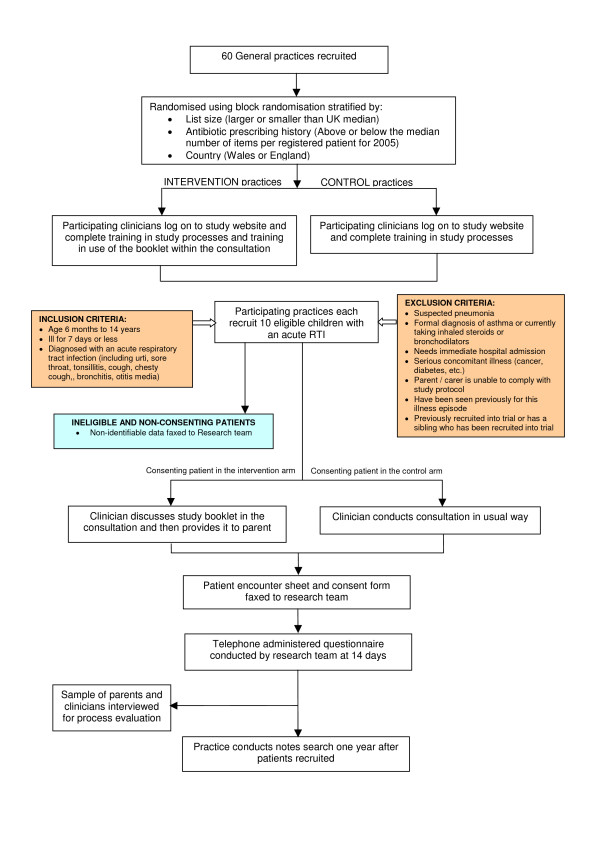
Study flow chart.